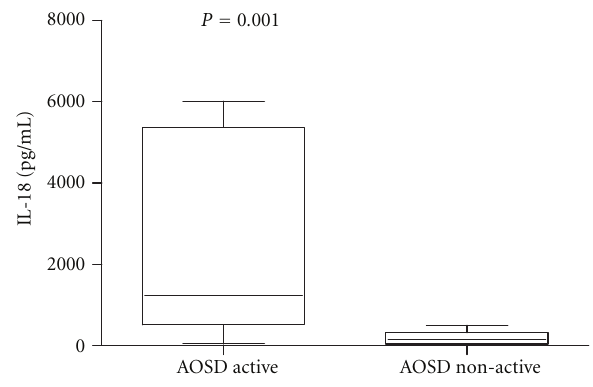
Figure 1: Box-and-whisker plot of IL-18 serum levels in patients with active AOSD ( n = 16) and non-active AOSD ( n = 10).